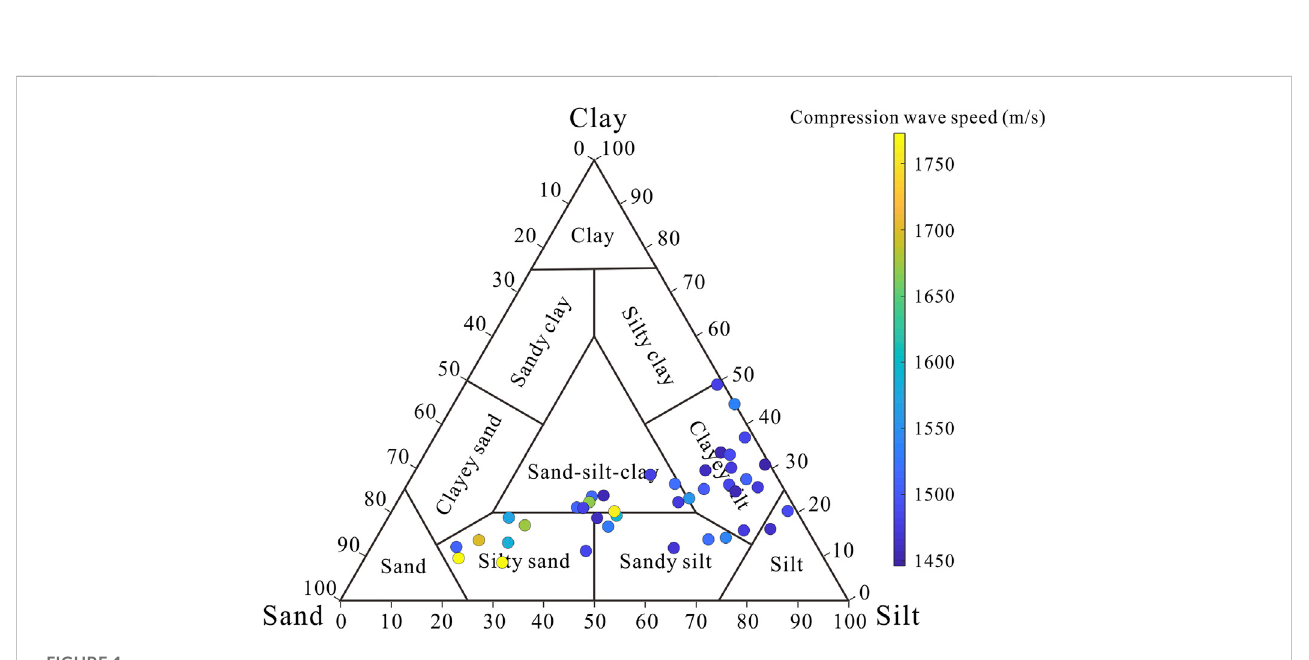
FIGURE 1 Sediment granularity triangle classi fi cation.